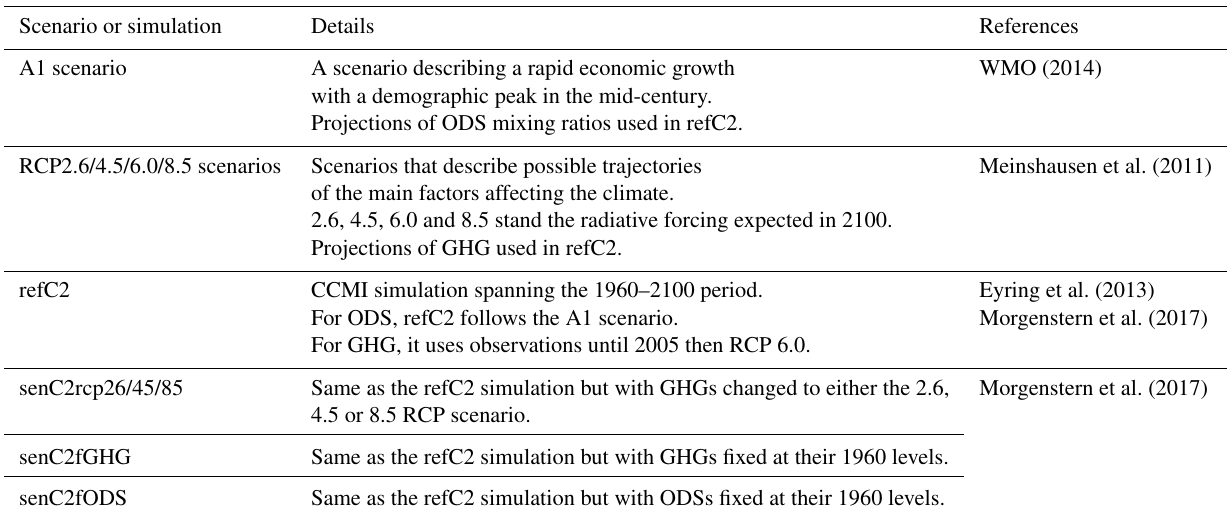
Table 3. Summary of scenarios and